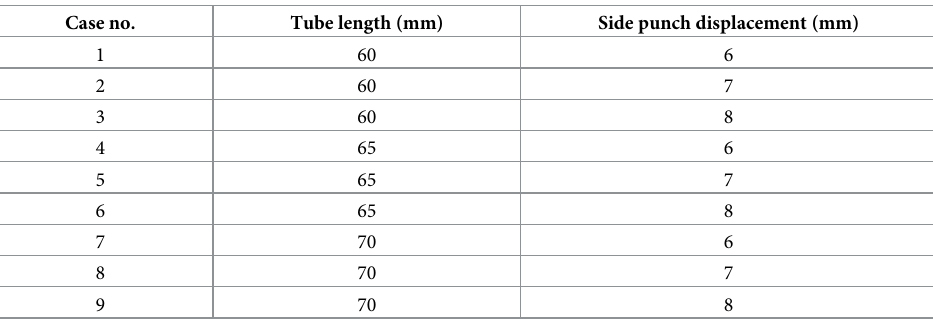
Table 3. Experiment runs. Case no.